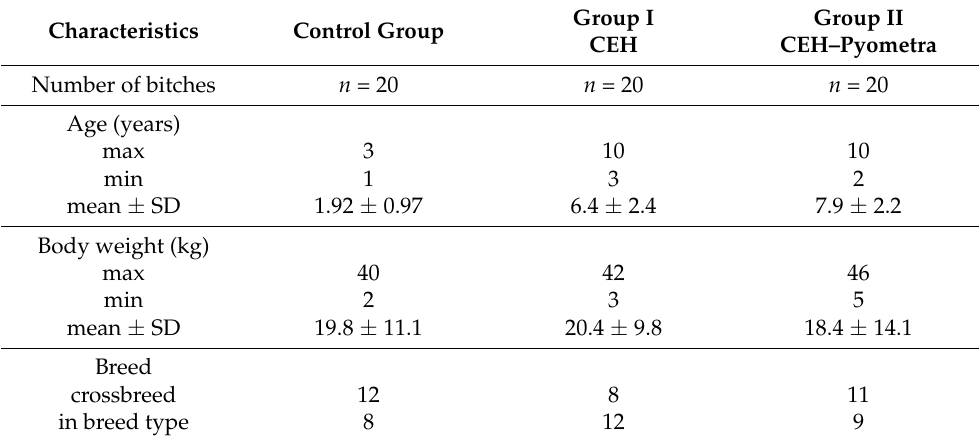
Table 1. Details of the animals (control group, cystic endometrial hyperplasia (CEH) and CEH- pyometra) used in the